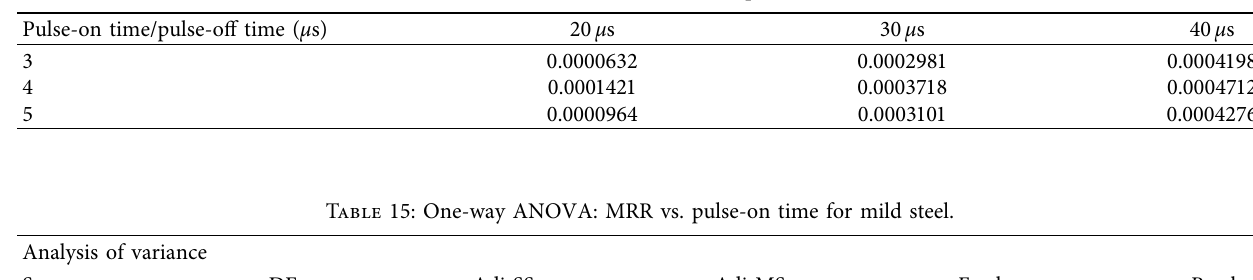
Figure 8: (a) Interval plot of MRR vs pulse-off time for aluminium. (b) Individual value plot of MRR vs pulse-on time for aluminium. (c) Box plot of MRR vs pulse-off time for aluminium. Table 14: MRR at different levels of pulse-on time.